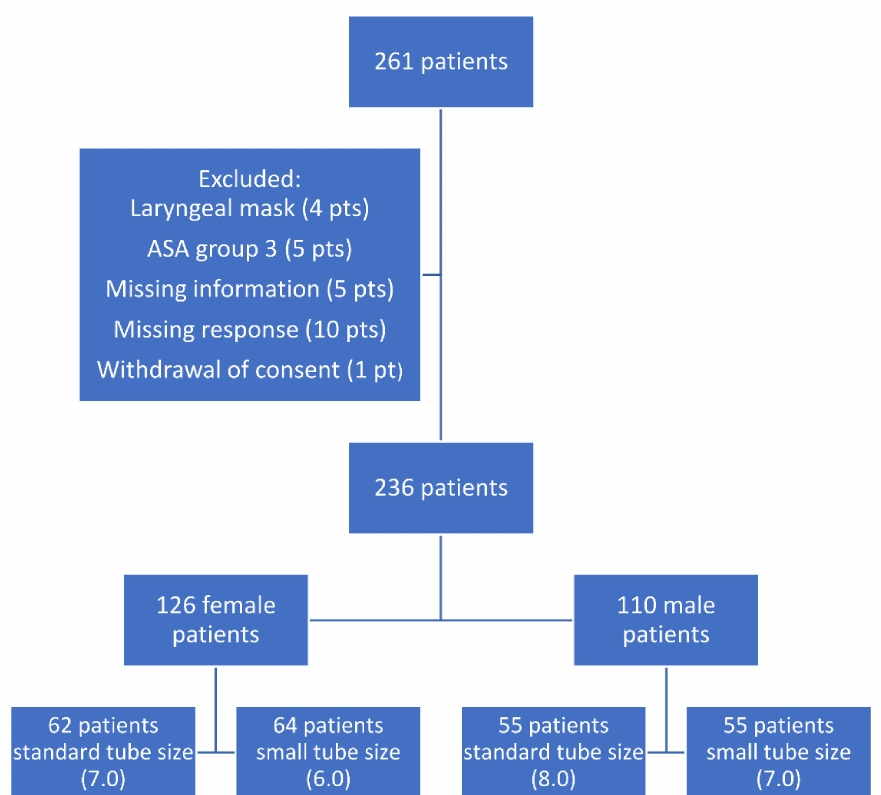
Figure 1. Flowchart of included